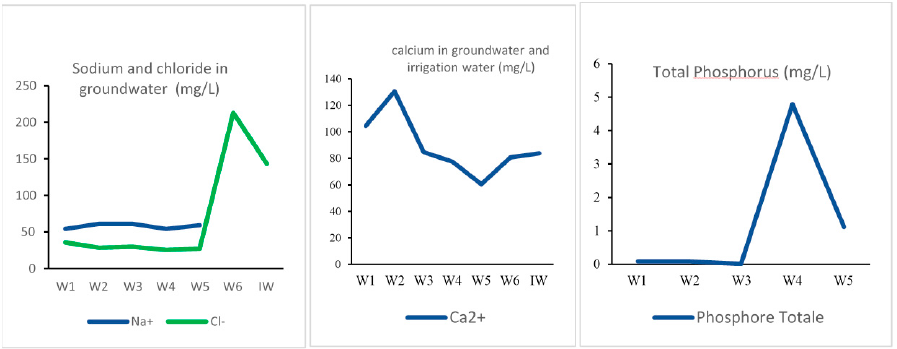
Figure 2. Sodium, Chloride, calcium and total phosphorus of groundwater samples in Souk-Sebt .